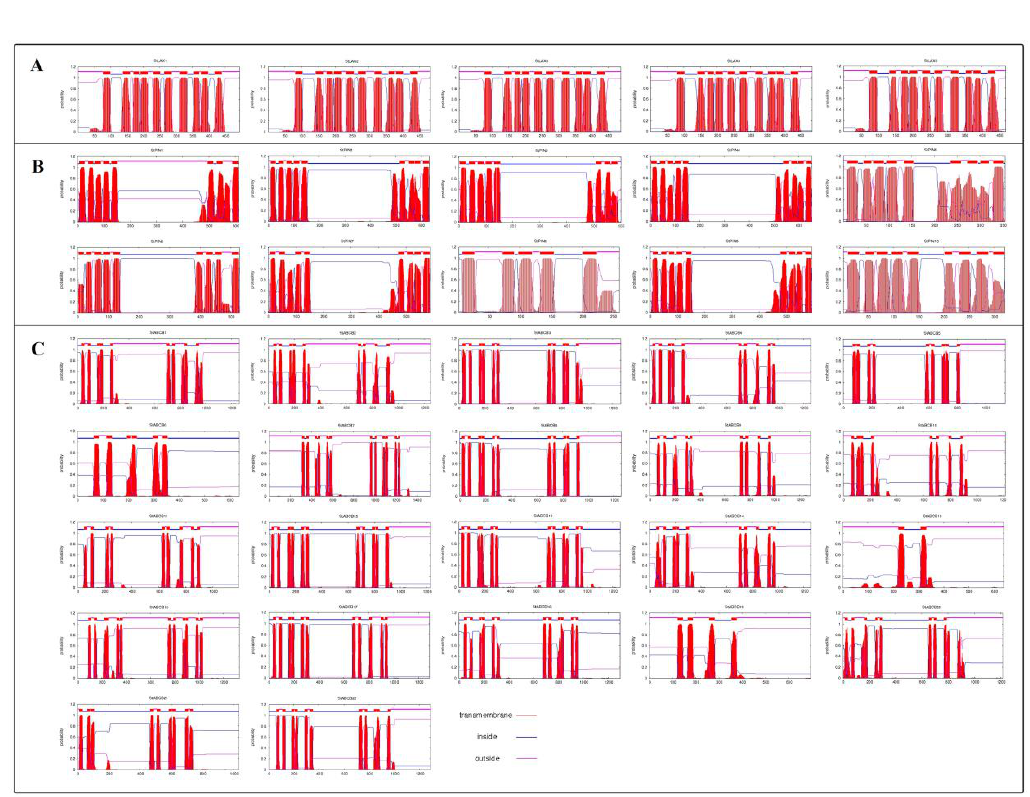
Figure A1. Transmembrane topology prediction for the StLAX ( A ), StPIN ( B ), and StABCB ( C ) proteins. The trans-membrane helices were predicted using the TMHHM v.2.0 (http://www.cbs.dtu.dk/services/TMHMM accessed on 31 May 2020) and the predicted trans−membrane hlices are shown as red peaks.